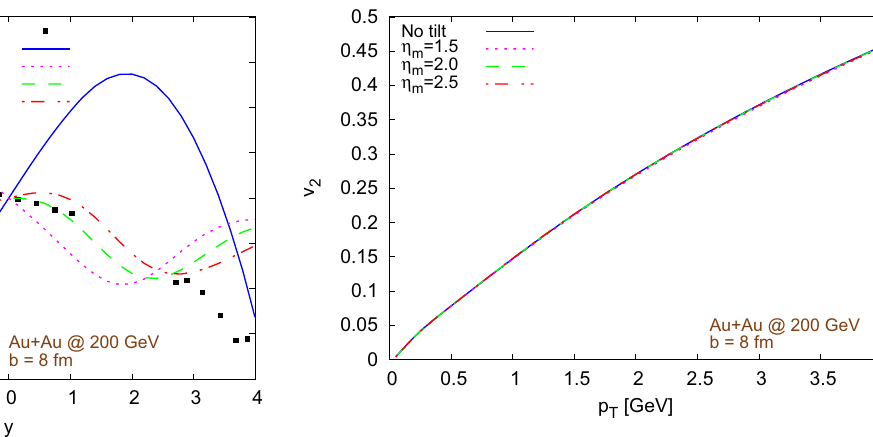
Fig. 13 Comparison between the outcomes of simulations with an ini- tial energy density distribution non tilted and tilted by using different values of the parameter η m . Left: directed flow v 1 versus rapidity y .